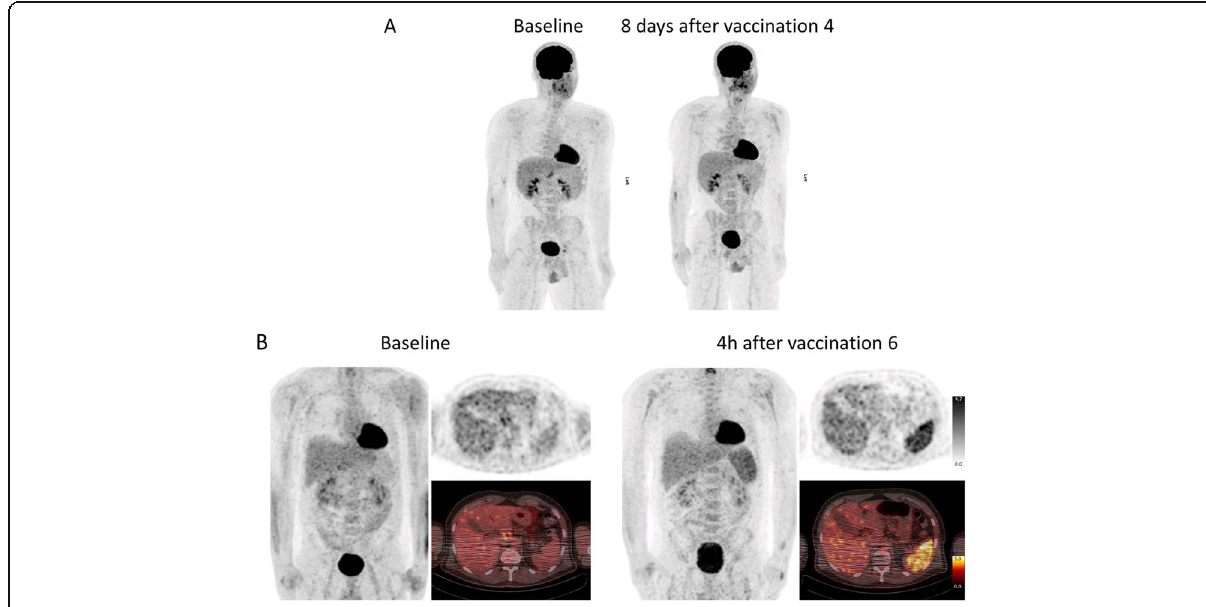
Fig. 5 Two clinical cases scanned before and during participation in a clinical vaccination study (LipoMerit). a One patient did not show alteration in FDG metabolism during the study when imaging was performed 8 days after the last vaccination cycle. b One other patient showed more than two times increased FDG uptake within the spleen when imaging was acquired 4 h after a vaccination